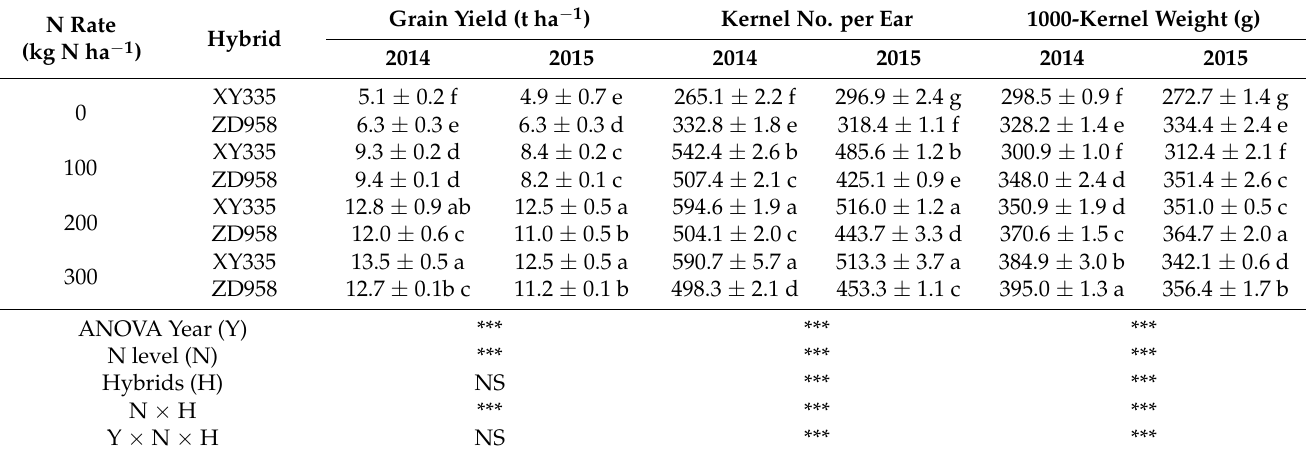
Table 1. Yields and yield compositions of maize of different genotypes at a high plant density in 2014 and